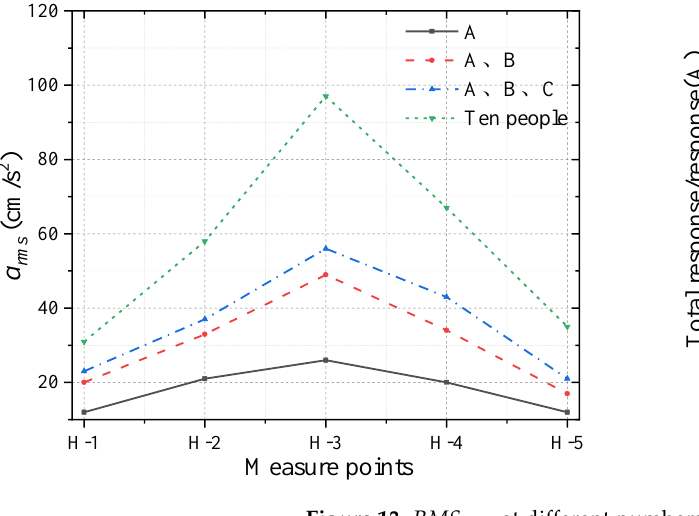
Figure 13. RMS max at different numbers.